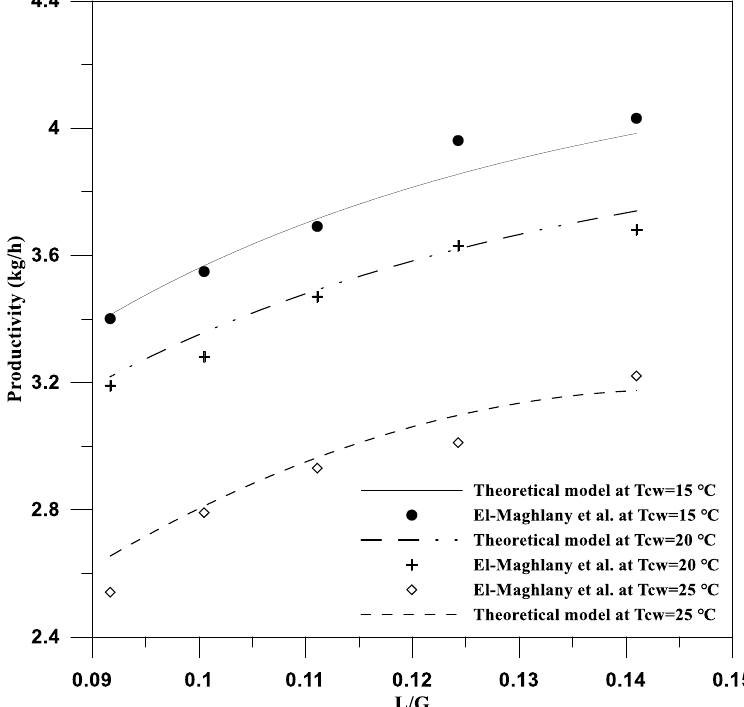
Figure 6. Productivity of the desalination unit using spraying atomization as a function of water to air mass ratios. Theoretical model results and experimental results of El Maghlany et al. [19], at different temperatures.